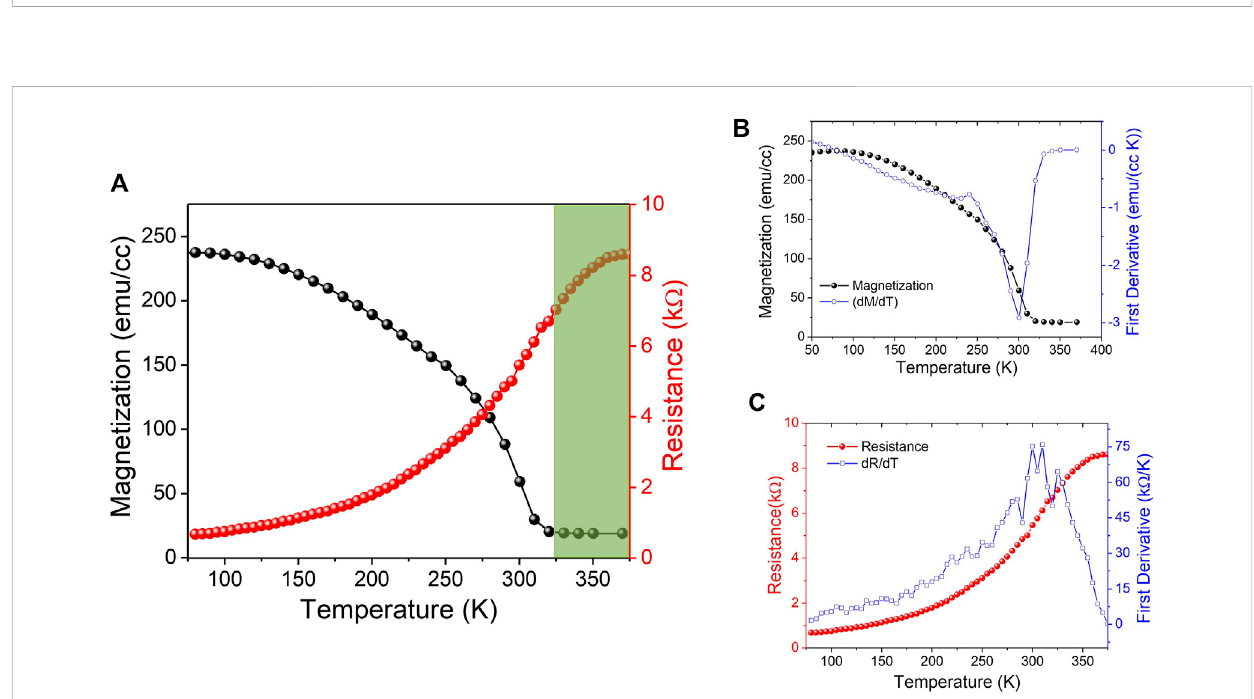
FIGURE 2 (A) Magnetization(black)andresistance(red)vstemperature.Theregioninwhiteistheferromagneticmetallicregime,andthegreen-shadedregion is the paramagnetic insulating regime. (B) Zero- fi eld-cooled magnetization vs temperature plot obtained with a running magnetic fi eld of 50 Oe shows that the fi lm follows the Curie – Weiss law exhibiting ferromagnetic behavior up to T C ~ 325 K, determined by the slope change ( dM / dT ) with respect to temperature. (C) Zero- fi eld-cooled resistivity vs temperature dependence obtained with a fi xed direct current of 1 µA in the van der Pauw con fi guration, which shows metallic behavior up to T MIT ~ 325 K, determined by the slope change ( dR / dT ) with respect to